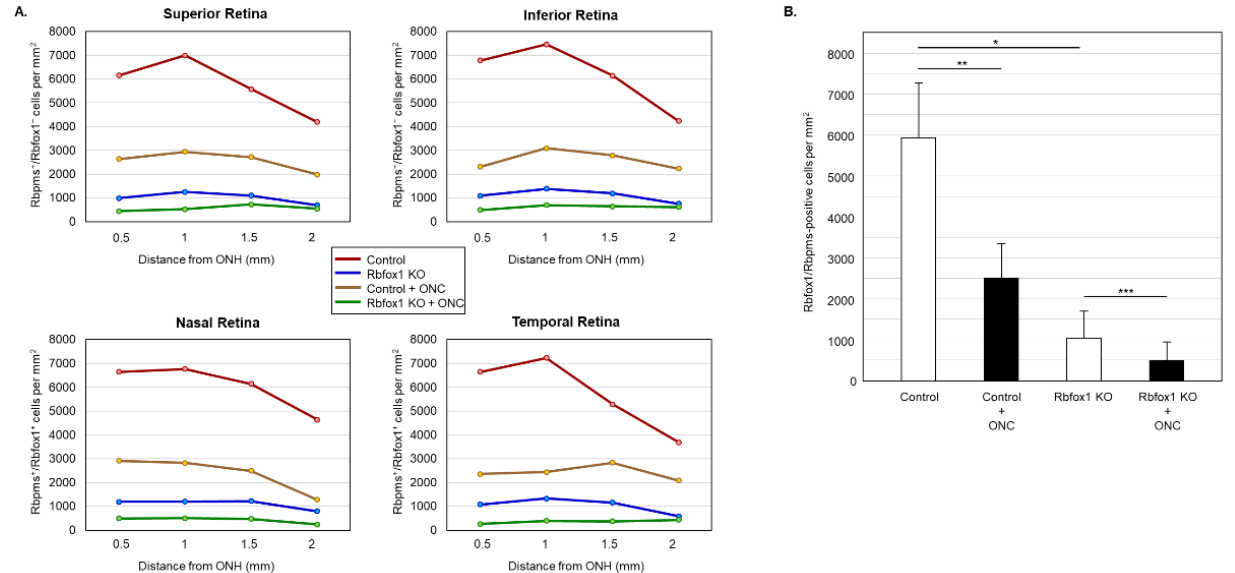
Figure 6. Downregulation of Rbfox1 and its effect on the survival of injured RGCs. For the quantitative assessment of Rbfox1 downregulation within RGC population, the numbers of Rbfox1/Rbpms-immunostained cells in control and Rbfox1 KO animals with and without ONC injury were counted ( n = 4/group). ( A ) A significant reduction of Rbfox1/Rbpms-positive cells in all four retinal quadrants of Rbfox1 KO mice compared to the control was observed. ( B ) The average densities of Rbfox1/Rbpms-positive cells in control and Rbfox1 KO retinas were 5911 ± 1557 cells/mm 2 and 1062 ± 634 cells/mm 2 , respectively. This indicates that more than 80% of RGCs in Rbfox1 KO animals are negative for Rbfox1 (* p = 4.50 × 10 − 47 ). ONC-induced loss of Rbfox1/Rbpms-positive cells was approximately 58% in control animals (5911 ± 1557 cells/mm 2 in control vs. 2215 ± 849 cells/mm 2 in control + ONC, ** p = 1.14 × 10 − 33 ) and ~50% in Rbfox1 KO animals (1062 ± 634 cells/mm 2 in Rbfox1 KO vs. 489 ± 340 cells/mm 2 in Rbfox1 KO + ONC, *** p = 3.19 × 10 − 9 ). ONC, optic nerve crush; ONH, optic nerve head. Table 2. Densities of Rbfox1/Rbpms-positive cells in retinas of control and Rbfox1 KO animals with and without ONC (per mm2).